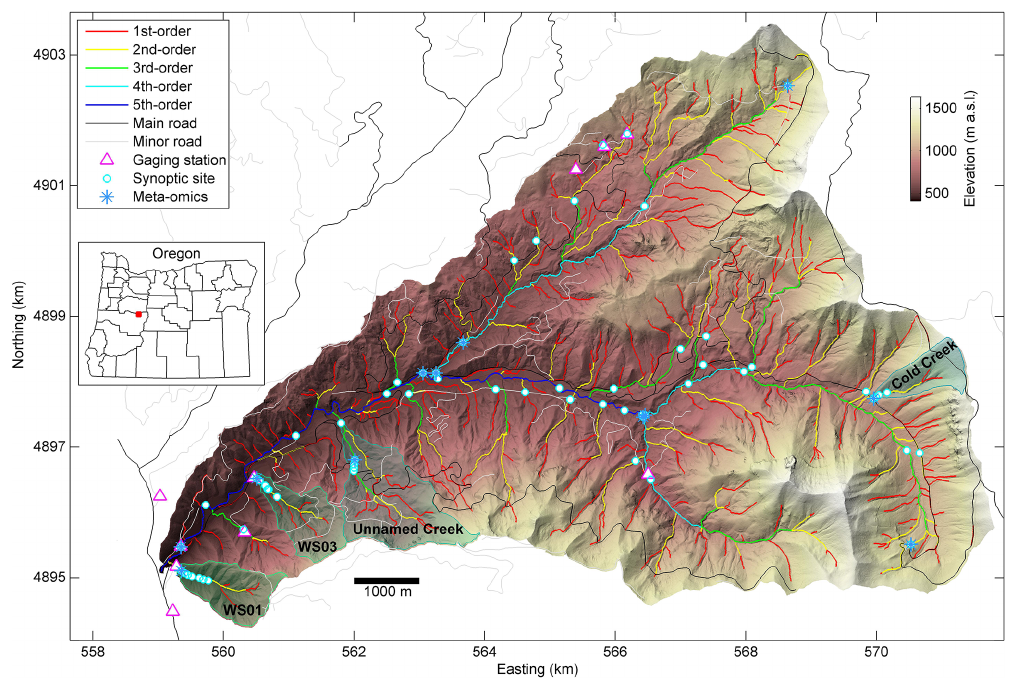
Figure 1. Synoptic sites and lidar-derived stream network (see details on network definition in Sect.